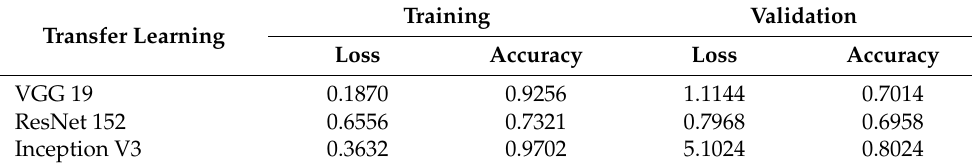
Table 5. Performance comparison of transfer learning